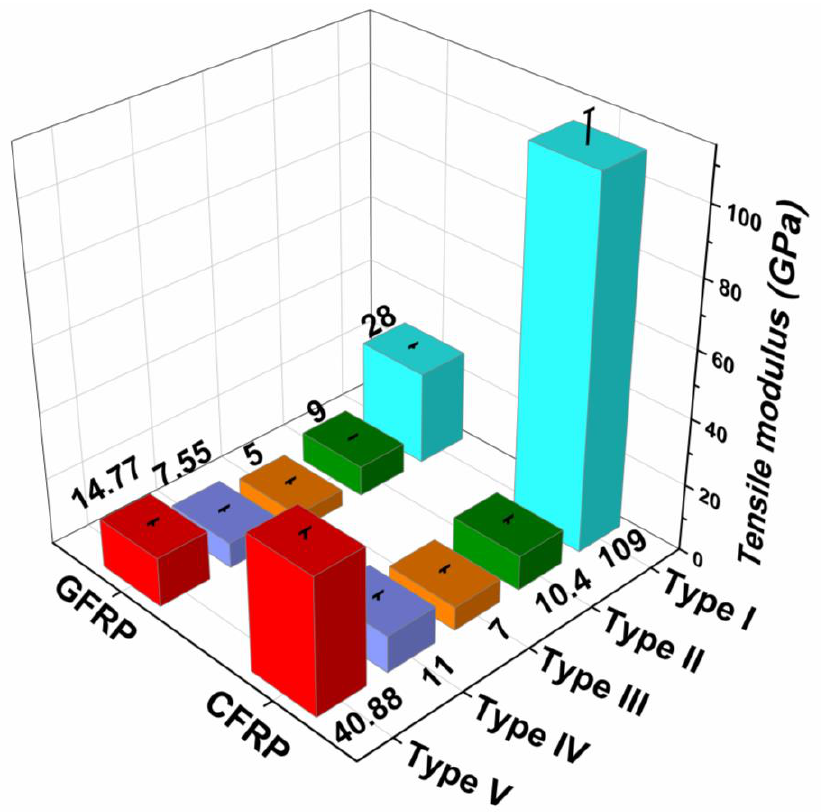
Figure 5. Average tensile modulus for different fiber orientations of GFRP and CFRP composites.